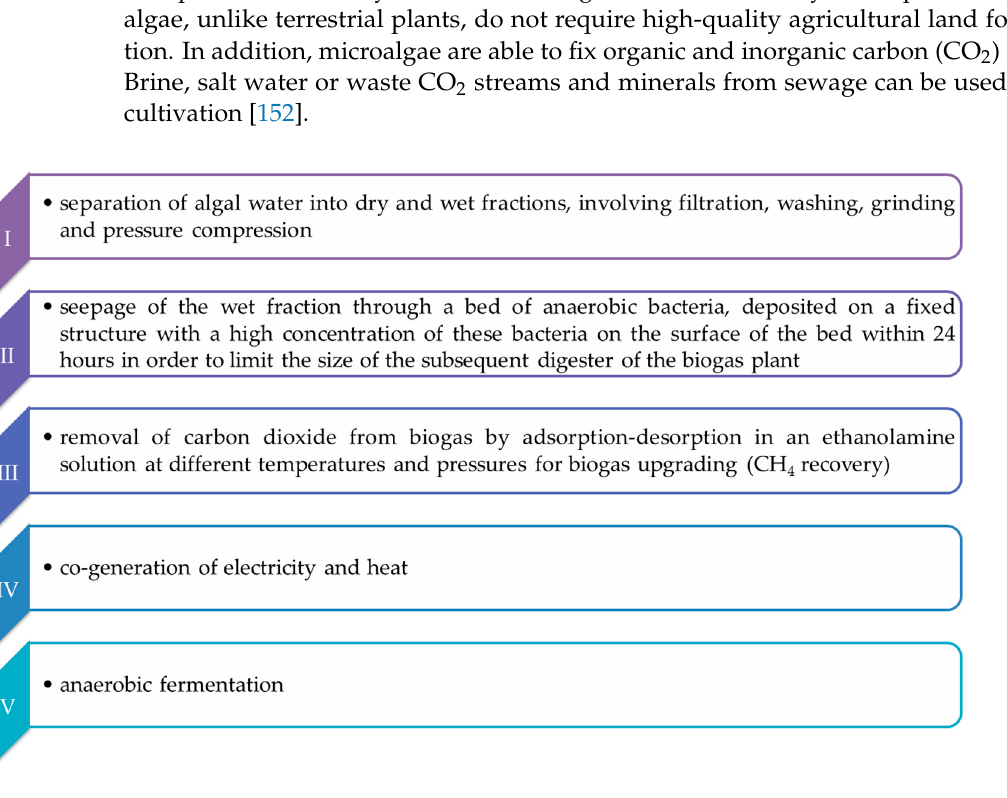
Figure 5. Steps involved in the technical processes for recovery of the energy from